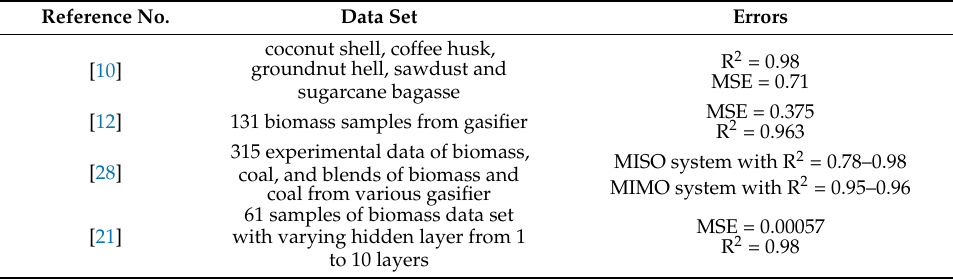
Table 1. Results reported by other researchers in